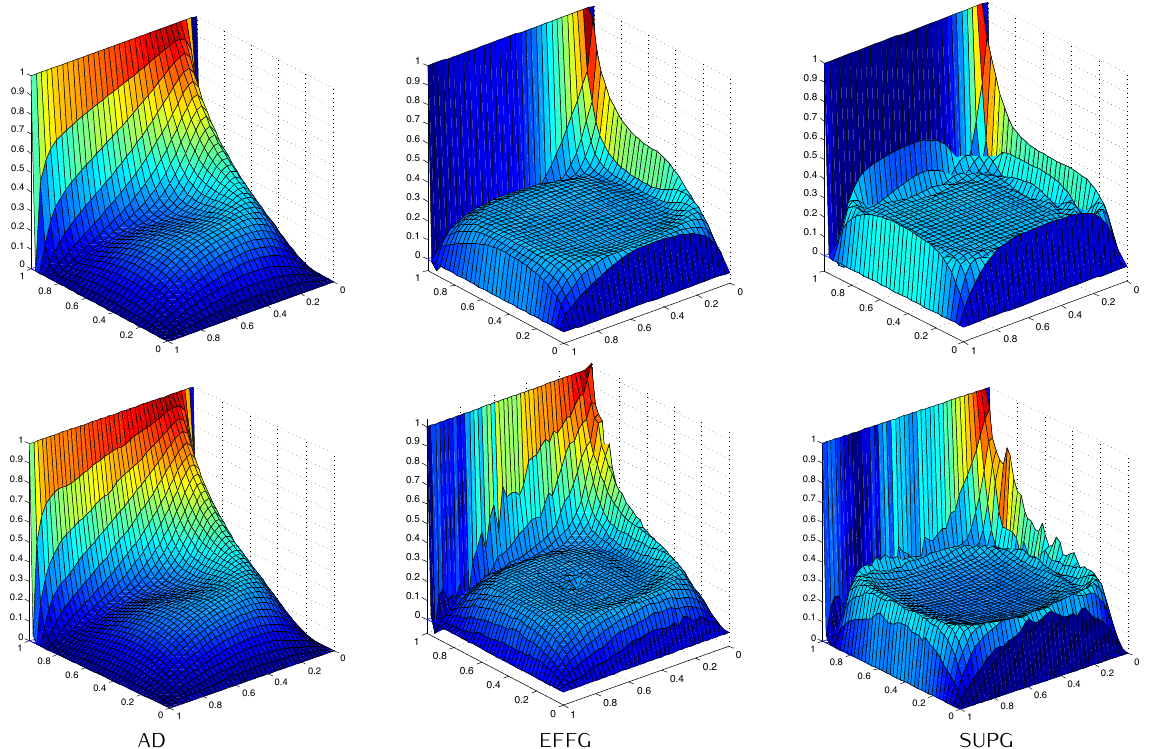
Figure 9. Surface plots of the solution of the double glazing test problem (31) with ε = 0 . 00001 by AD (left) vs. EFFG (middle) and SUPG (right) on 33 × 33 grids. Top row: uniform grid. Bottom row: randomly perturbed